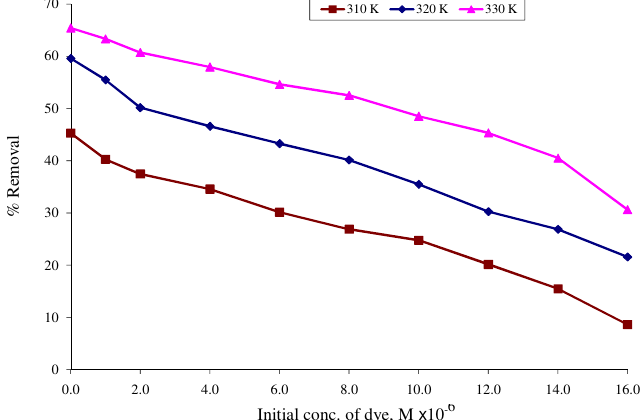
Figure 4. Effect of initial concentration of TSP with different